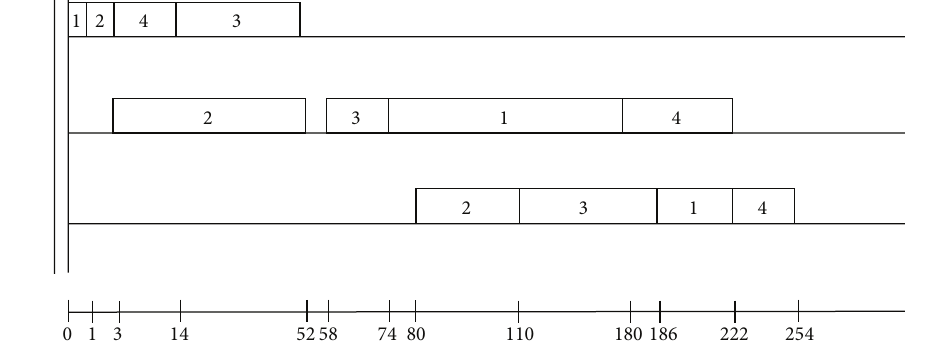
Figure 10: Schedule provided by 𝐻1 for Example 4.